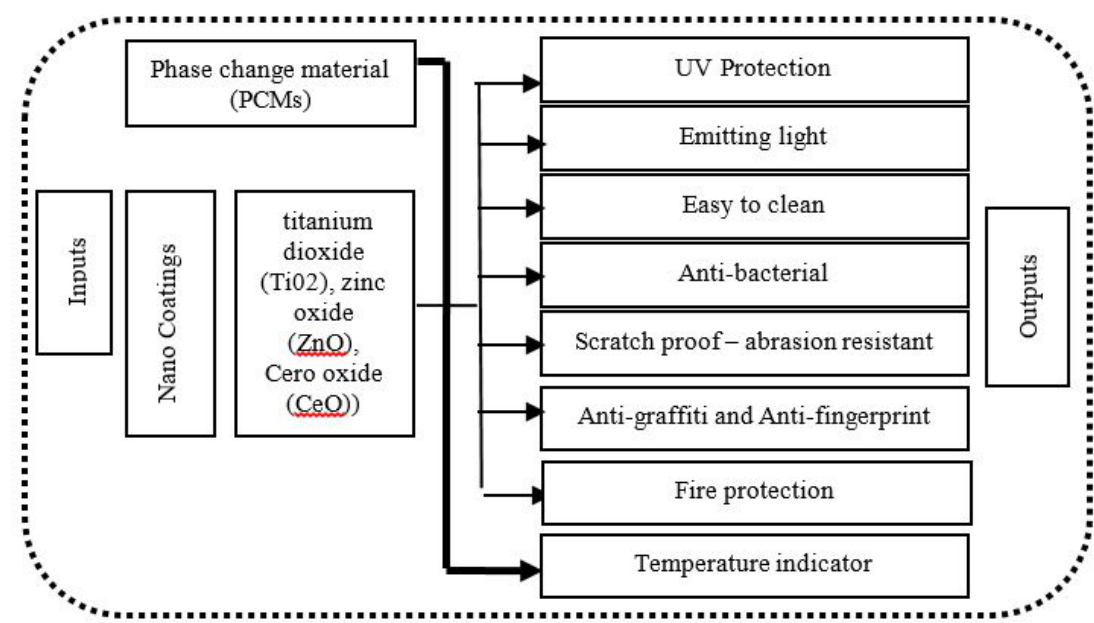
Figure 14. the inputs and outputs of smart and nanomaterials on the finishing ( the authors)